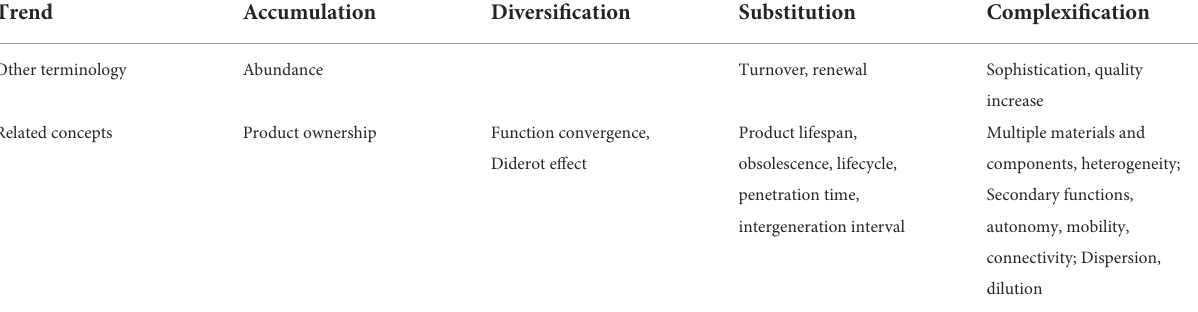
TABLE 3 Outcomes drawn from the integrative review.